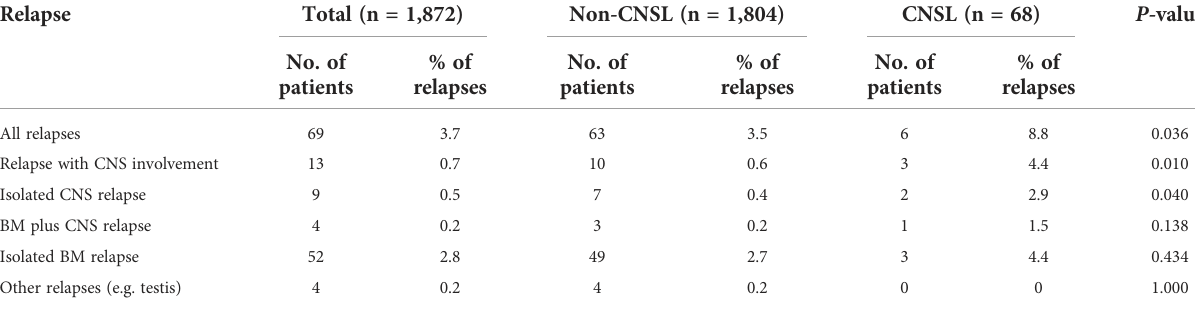
TABLE 2 Distribution of relapse according CNS status at